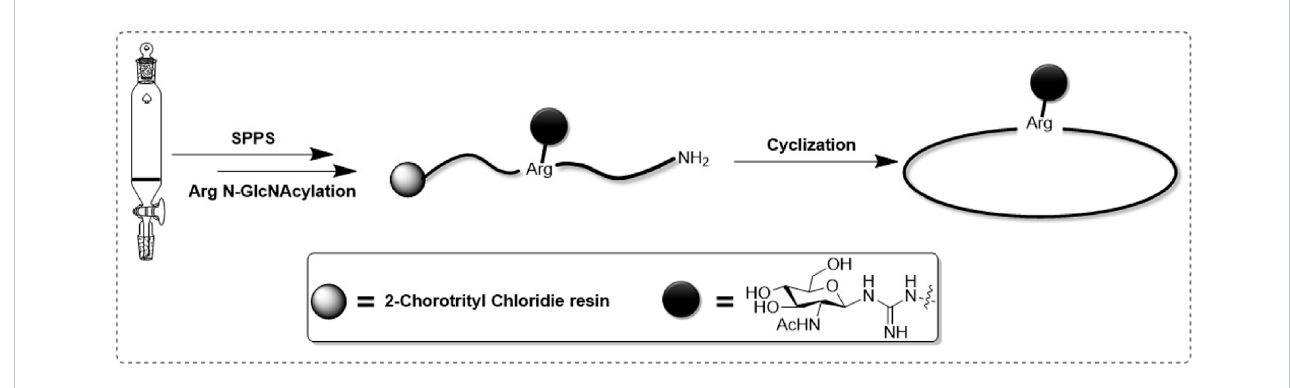
FIGURE 2 Synthesis of Arg-glycosylated cyclic